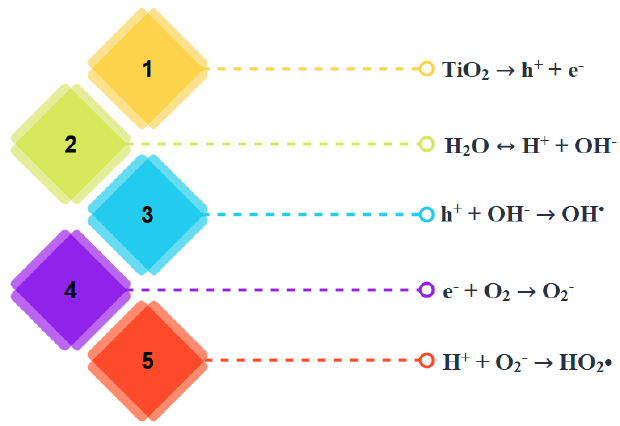
Figure 2. Photocatalytic reactions based on the electronic structure of semiconductors.